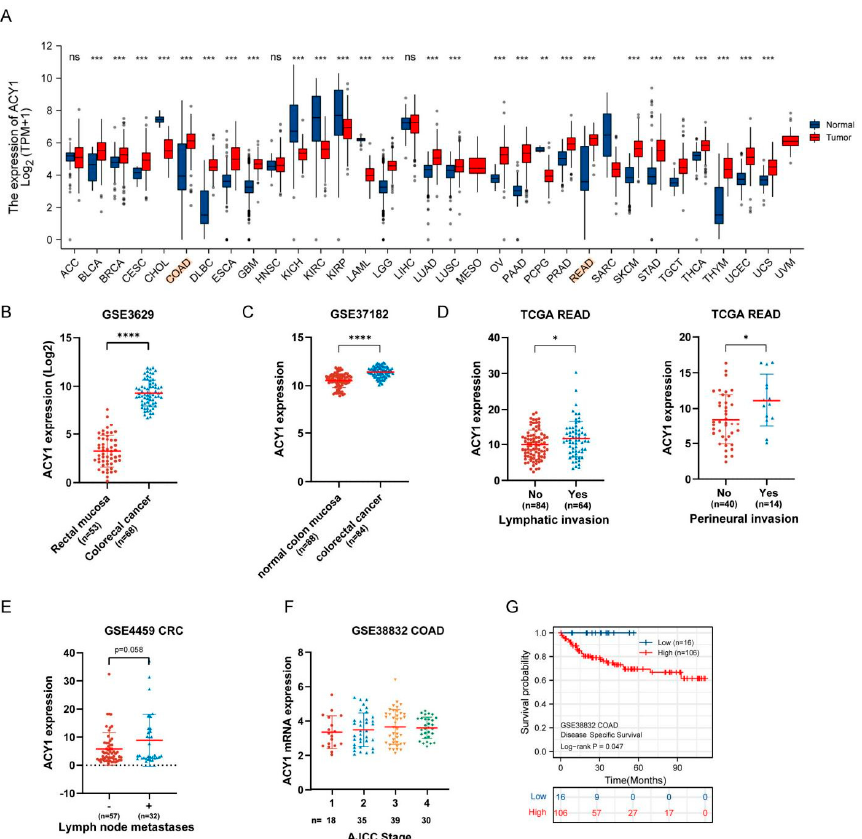
Figure 2. ACY1 expression in human cancers and its relationship with clinical severity stratification and prognosis in CRC patients. ( A ) ACY1 expression levels in diverse tumors and adjacent noncancer- ous tissues from TCGA database. Comparison of ACY1 expression in tumors and corresponding normal tissues in different types of cancer. (Red indicates tumor samples; blue indicates noncancer- ous samples). ACC, adrenocortical carcinoma; BLCA, bladder urothelial carcinoma; BRCA, breast invasive carcinoma; CESC, cervical squamous cell carcinoma and endocervical adenocarcinoma; CHOL, cholangiocarcinoma; COAD, colon adenocarcinoma; DLBC, lymphoid neoplasm diffuse large B-cell lymphoma; ESCA, esophageal carcinoma; GBM, glioblastoma multiforme; HNSC, head and neck squamous cell carcinoma; KICH, kidney chromophobe; KIRC, kidney renal clear cell carcinoma; KIRP, kidney renal papillary cell carcinoma; LAML, acute myeloid leukemia; LGG, brain lower grade glioma; LIHC, liver hepatocellular carcinoma; LUAD, lung adenocarcinoma; LUSC, lung squamous